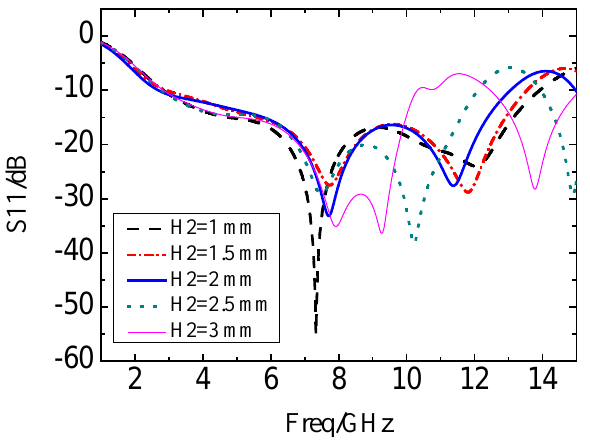
Figure 8. Simulation results of the reflection coefficient with different H 2 .